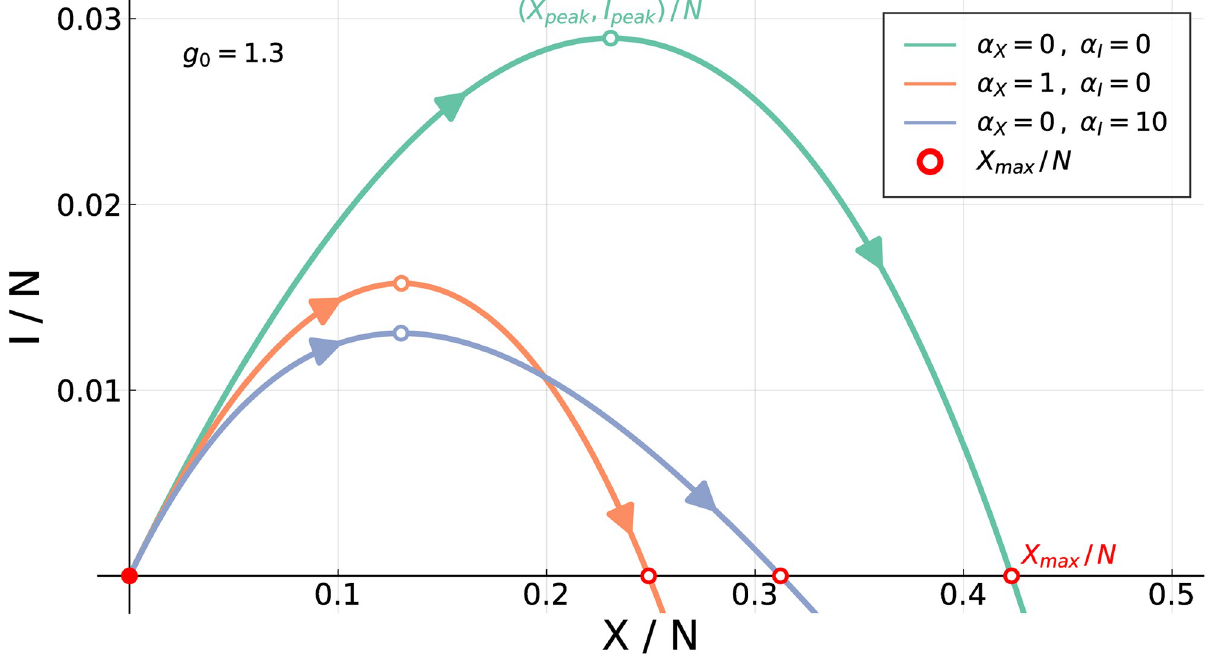
Fig 1. Short and long-term control. Outbreaks are contained when either short-term or long-term control is present, see Eqs (1) and (2). Long-term control ( α > 0, α = 0) produces more symmetrically confined outbreaks than short-term control ( α X I